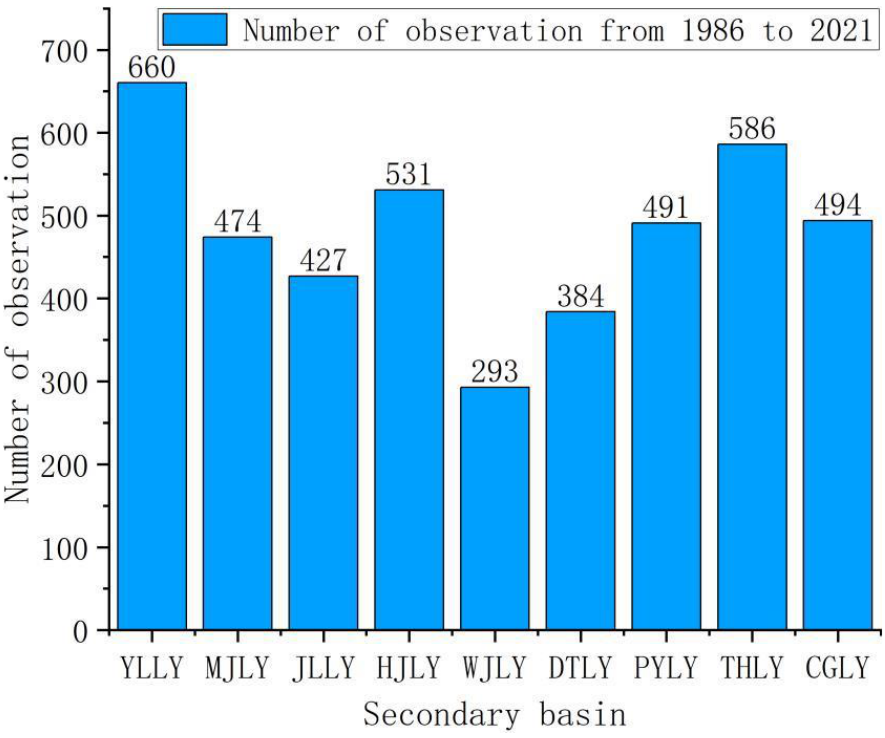
Figure 3. Effective Landsat observations in the secondary basin from 1986 to 2021.